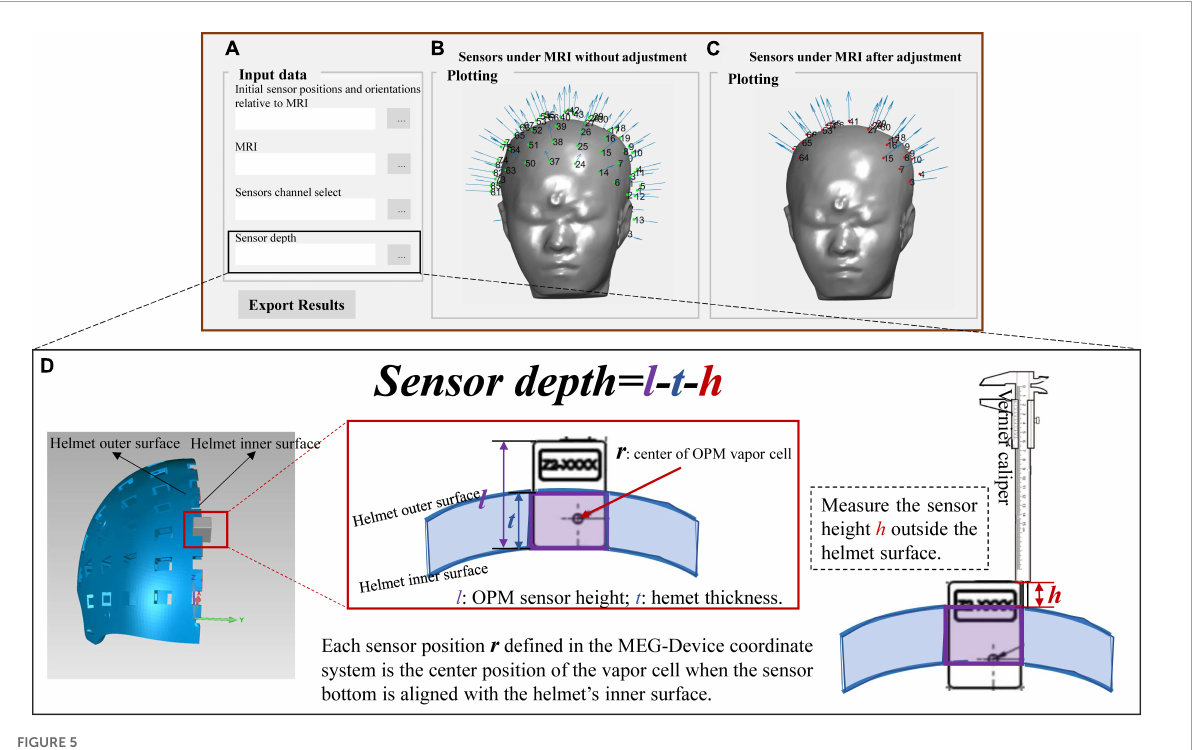
FIGURE5 (A) Interface for importing data and exporting data; (B) the results of co-registration under MRI coordinate system in initial position; (C) the final co-registration results; (D) the illustration of the sensor